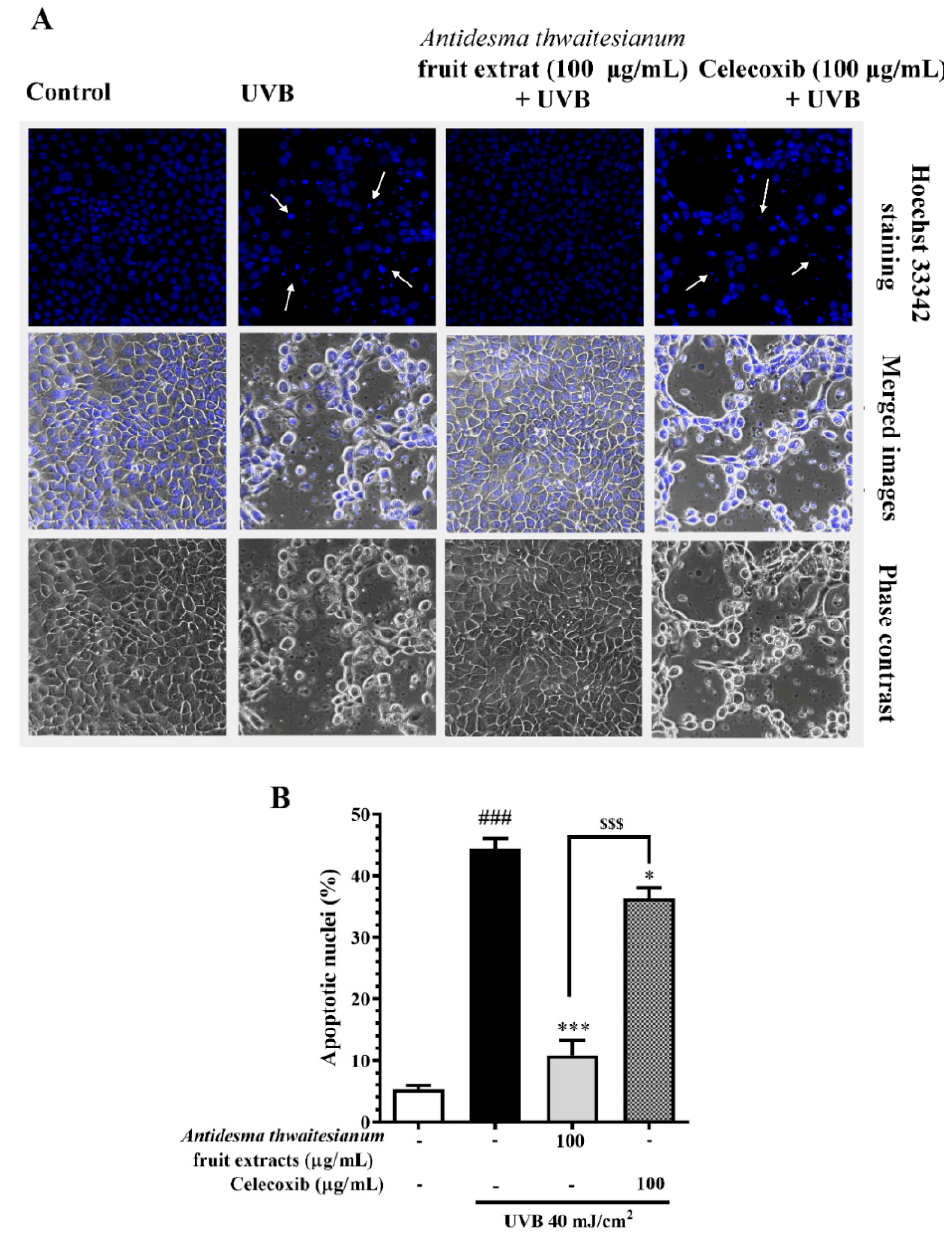
Figure 5. The photoprotective effect of the fruit extract following UVB-induced apoptosis. ( A ) shows the Hoechst 33342 nuclei staining after pre-incubating cells with the fruit extract for 2 h, exposed to single UVB irradiation, and further incubating for 24 h. ( B ) shows the relative fluorescence intensities, which are represented as mean ± SEM (n = 6) and analyzed with Tukey’s test. The inserted image shows the magnified apoptotic nuclei of the UVB-treated cells (40 × magnification of objective lens). ### p < 0.001 versus the control group, * p < 0.05 and *** p < 0.001 versus UVB-irradiated cells alone. The statistical difference between the extract and celecoxib at 100 µg/mL was at $$$ p < 0.001. 2.4. The Effects of the Extract on UVB-Induced Cellular p38 and JNK Phosphorylation UVB has been previously described as a stress activator of two MAPK signaling path- ways: p38 and JNK [13,14]. The activation of MAPK occurs through the phosphorylation of their tyrosine residue. In this study, the level of phospho-p38 increased 2.21 ± 0.19-fold